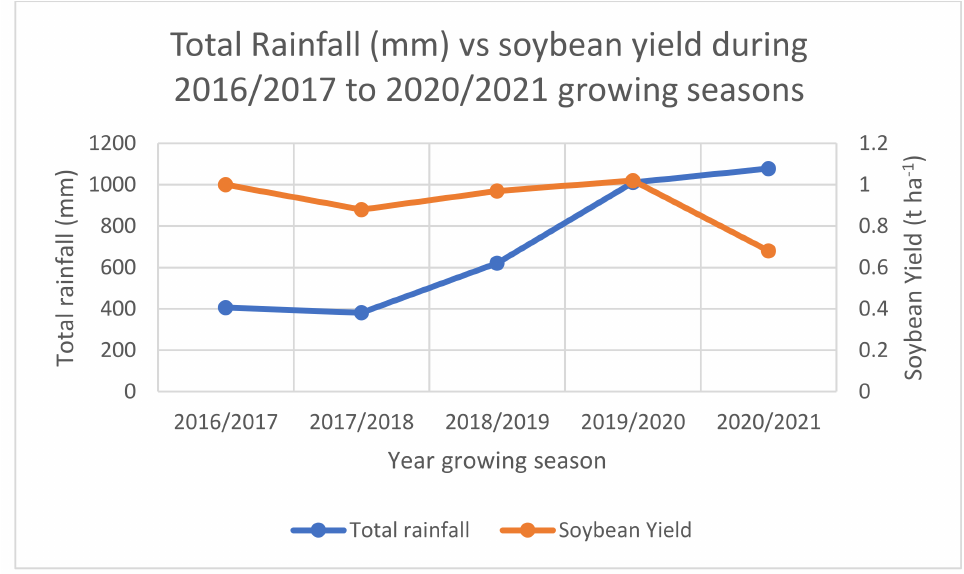
Figure 8. Relationships between total rainfall and soybean yields during 2016/2017 to 2020/2021 growing seasons. Blue: Total rainfall. Source: Weather and Climate [34]; Yellow: soybean yield. Source: own data gathered from survey during the